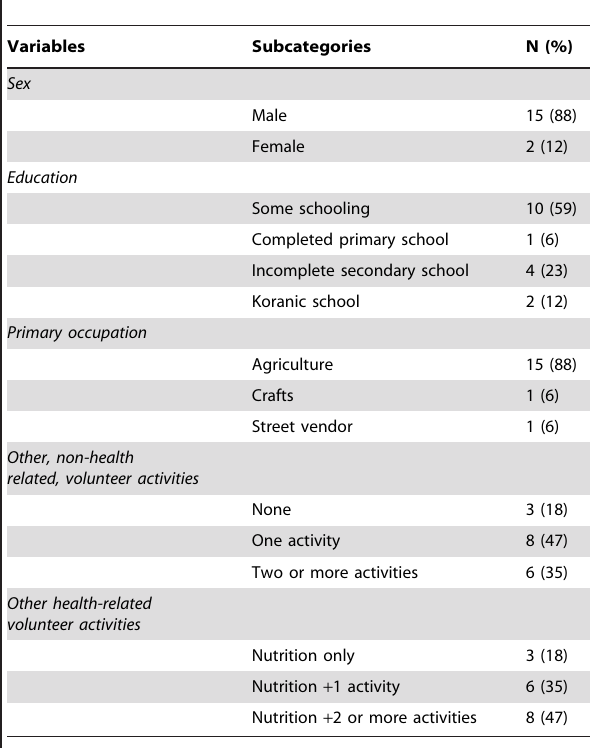
Table 3. Description of community volunteers participating in the study (N =17).